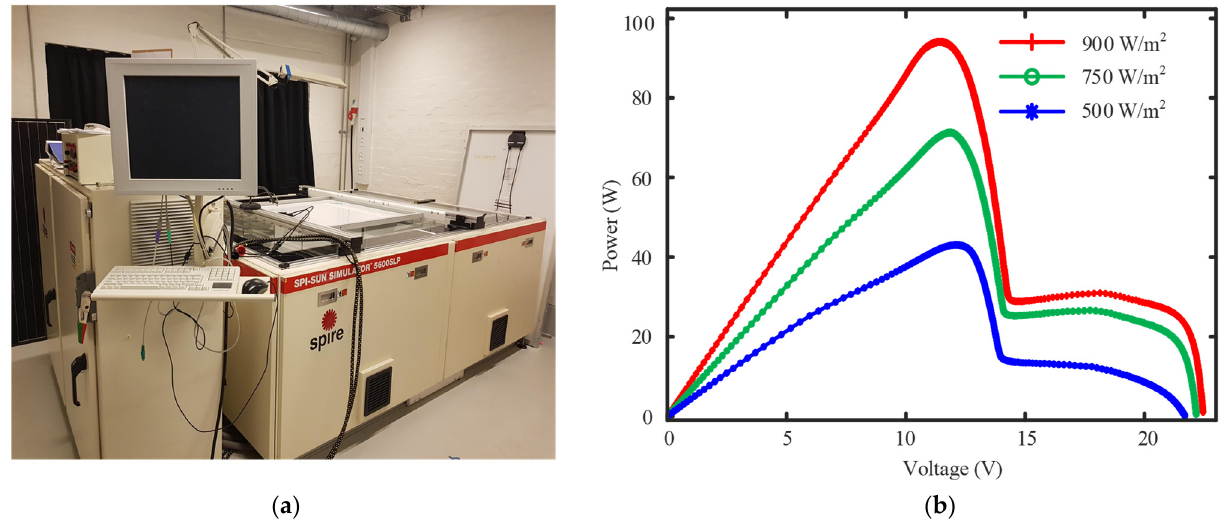
Figure 4. Experimental evaluation of the mismatch effect on a solar PV module (Solvis: SV36-150) containing three submodules with bypass diodes: ( a ) SPI-SUN 5600 SLP solar sun simulator, ( b ) Power-voltage ( P-V ) characteristics when one of the PV cells is shaded from the three submodules and overall irradiance levels are 900 W/m 2 , 750 W/m 2 , and 500 W/m 2 .